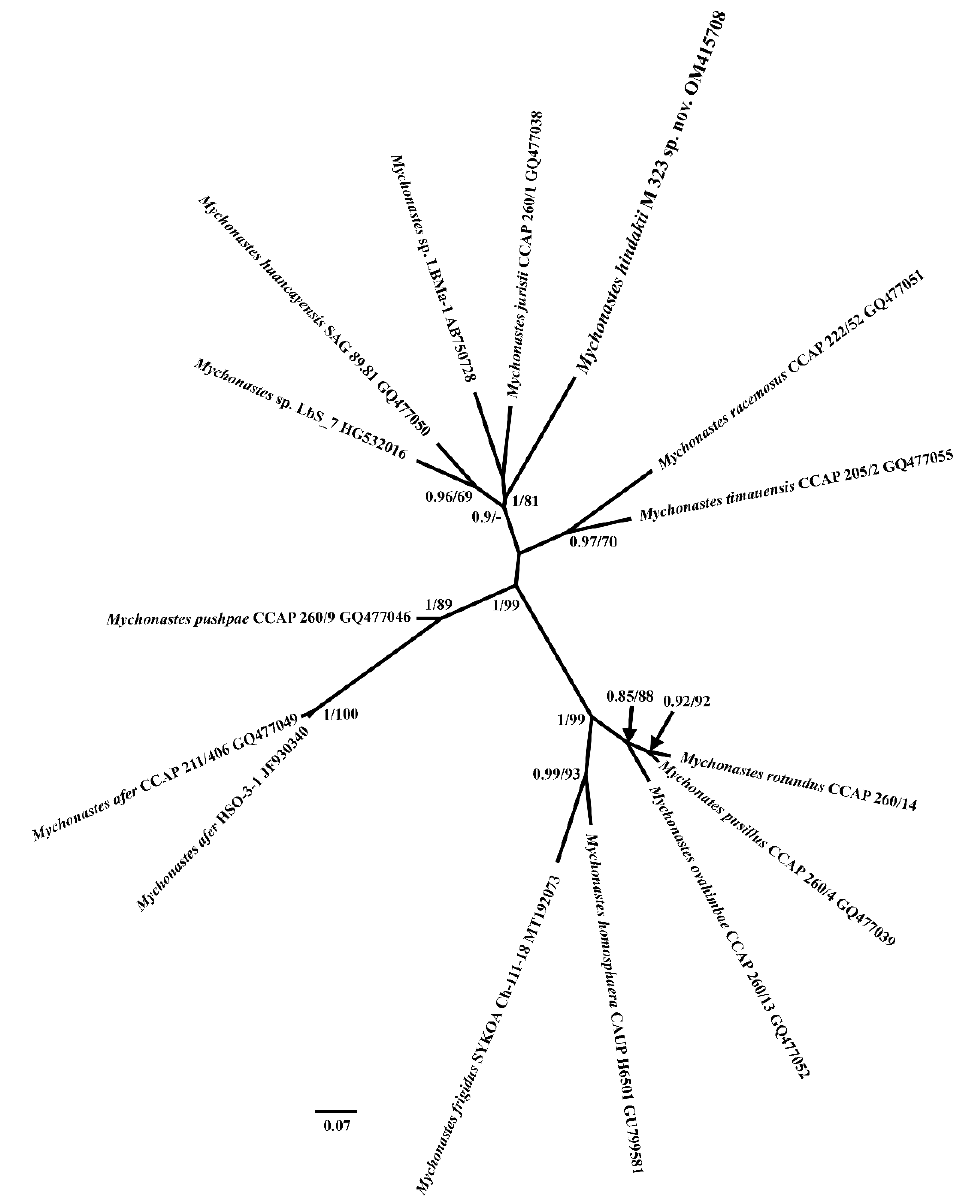
Figure 3. Unrooted maximum likelihood tree of the ITS2 rDNA of species from the genus Mychonastes . The Bayesian posterior probability and maximum likelihood bootstrap values are shown to the left and right of the fraction line respectively. Scale bar represents the substitution per site. and ML bootstrap (1/81). The ITS2 sequence data show that M. hindakii is included in a clade that consists of two morphologically different species: M. jurisii and M.